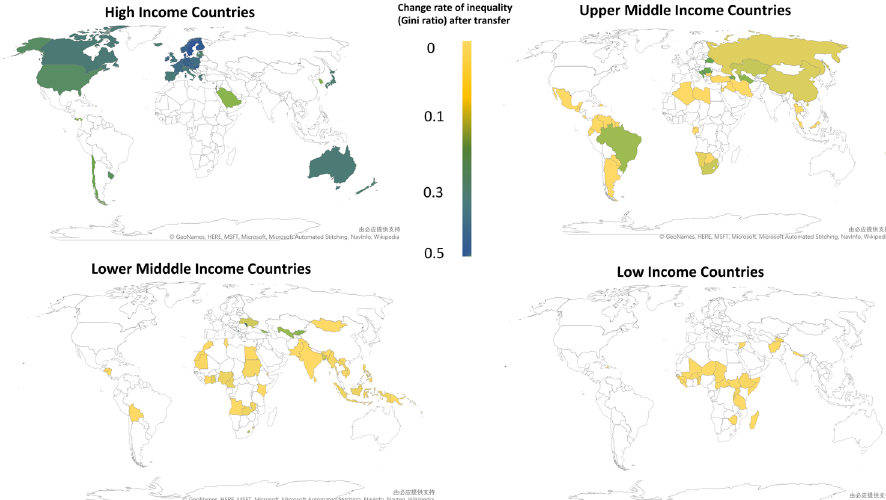
Fig. 2 Impact of redistribution on income inequality. This reports the change rate in the Gini ratios after transfer by country groups in the latest year, showing that fi scal transfers exert little impact on income inequality in developing countries, especially those with a middle or lower development status. Notes: (1) The classi fi cation of countries is based on the World Development Report 2017 1 . (2) Pre-transfer and post-transfer income inequality (Gini ratio) is based on the Standardized World Income Inequality Database (SWIID v7.1) of Solt 26 . (3) The two welfare de fi nitions employed in the SWIID are: (1) market income (pre-tax, pre-transfer income) refers to the amount of money coming into the household, excluding any government cash or near-cash bene fi ts as well as private transfers such as gifts, alimony, or assistance from nonpro fi t organizations, implying that market measures do not consider any fi scal policies or policies of redistribution; (2) net income (post- tax, post-transfer income) is the sum of market income and transfer payments, excluding direct taxes (Solt, 2016) 26 . (4) The change rate of inequality is de fi ned as relative redistribution (market income inequality minus net income inequality, divided by market income inequality). (5) The SWIID maximizes comparability for the broadest possible coverage of countries and years, which is ideal for broadly cross-country research into inequality. Therefore, when calculating the impact of redistribution on income inequality countries of 179 countries, they are comparative due to the same de fi nition of income and